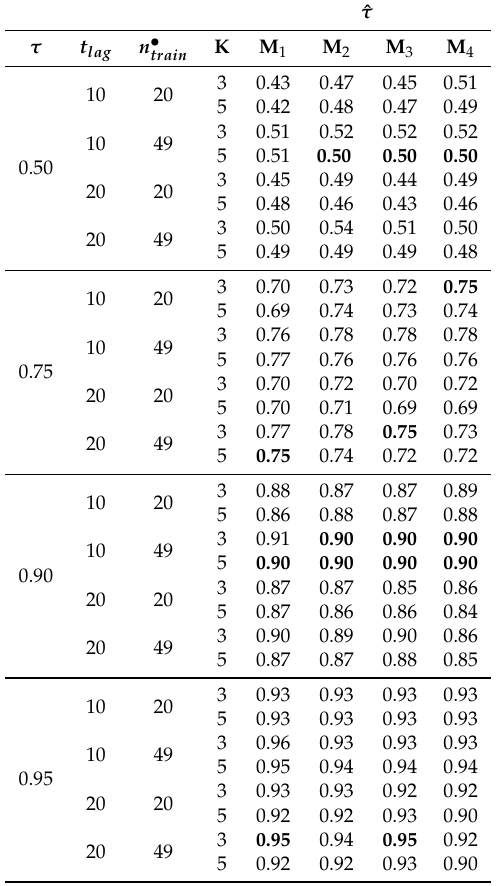
Figure 2. Observed and forecasted concentrations of SO 2 and NO x for two pollution episodes. The nominal and the estimated coverages for different time lags and training sample sizes are shown in Table 2. The coverages correspond to the bivariate solution, and were obtained for n test consecutive observations that might or might not correspond to pollution incidents. Table 2. Nominal τ and estimated ˆ τ coverages for each of the four models under study. Two time lags, t lag = 10, t lag = 20, two sizes of the training sample n train = 10,000 and n train = 4900, and two numbers of principal components, K = 3 and K = 5, were considered. Results correspond to the test sample. ˆ